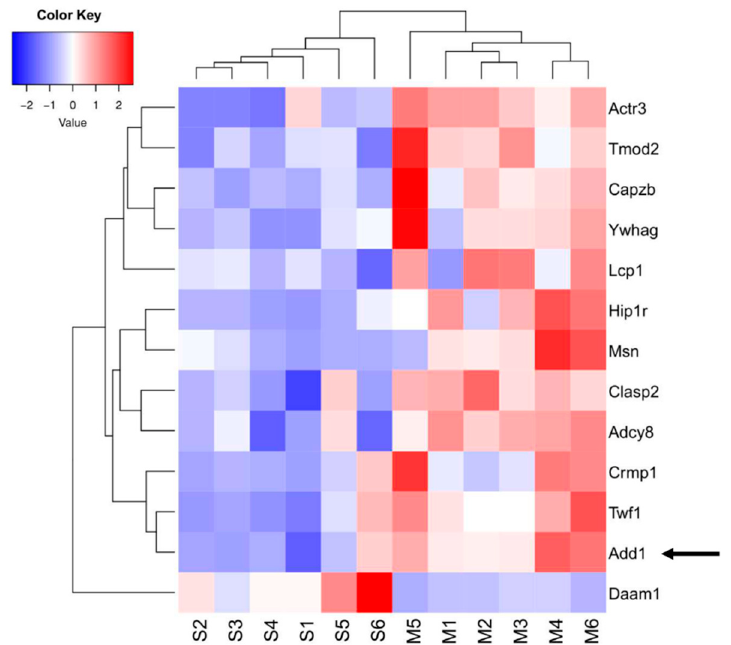
Figure 4. Heatmap visualization of differentially regulated proteins associated with actin-binding and negative regulation of protein depolymerization from ClueGO analysis features measured in the saline and midazolam-exposed samples from all six biological replicates from each group. The arrow highlights alpha-adducin (protein selected for post validation).